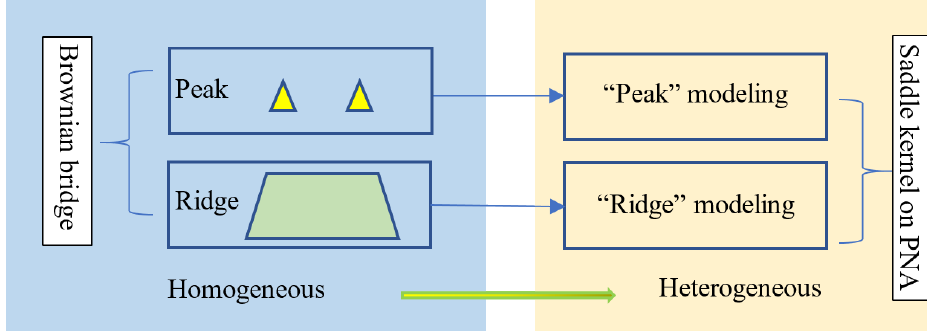
Figure 3. The mapping between the saddle shape of the Brownian bridge and the kernel function of the PNA.